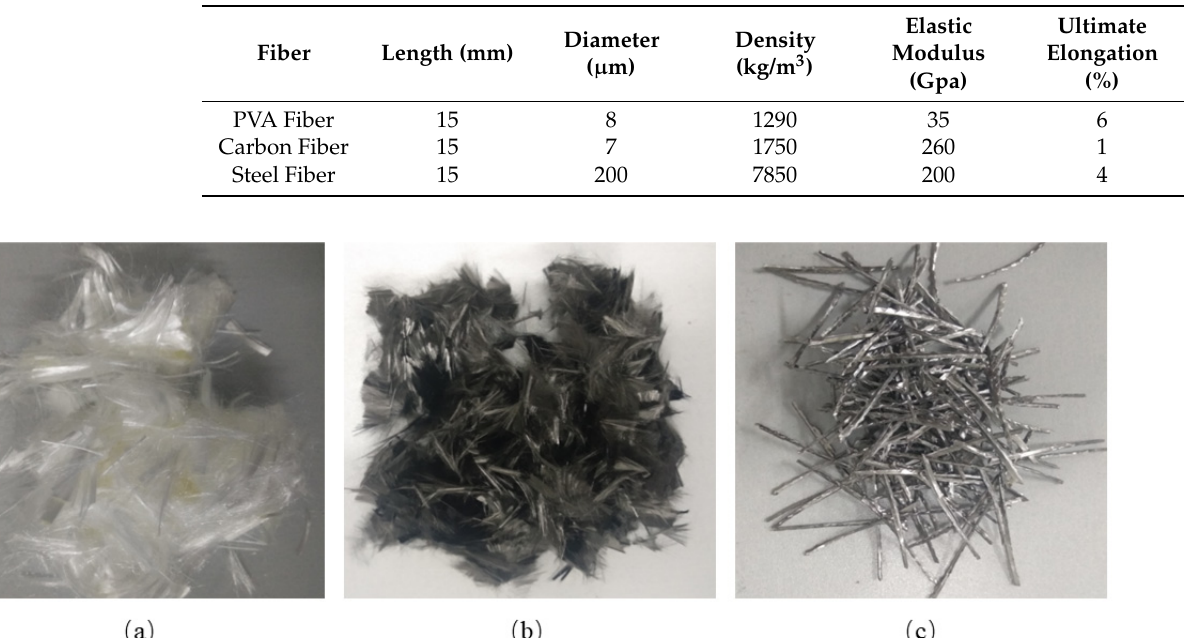
Table 2. Fiber specifications.